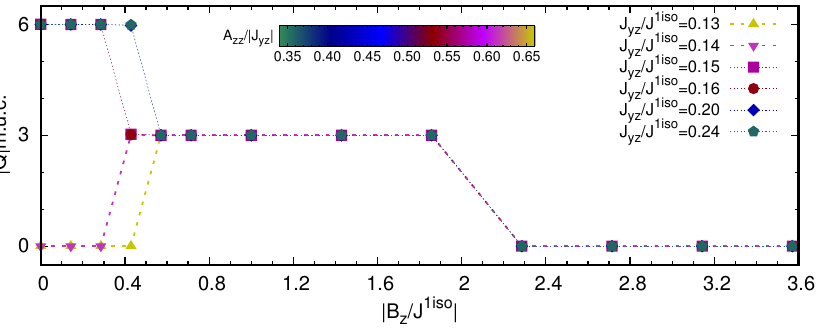
Figure 6. Evolution of | Q | per magnetic unit cell ( L m . u . c . = 8 a 0 ), as a function of the magnetic field B z for different off-diagonal terms, while keeping fixed diagonal exchange parameters and easy-plane anisotropy to values reported in Table 1. The color gradient of the solid points evolves with the A zz / | J yz | ratio. At zero and low B z field, the system stabilizes a proper screw like the A-phase for J yz / J 1 iso ≤ 0.14, and the topological lattice of the C-phase for J yz / J 1 iso > 0.14. At intermediate B z , the system undergoes a topological phase transition to a Bloch-type skyrmion lattice, E-phase. At high B z , the transition to the ferromagnetic state, I-phase, takes place passing trough the trivial triple- q state,